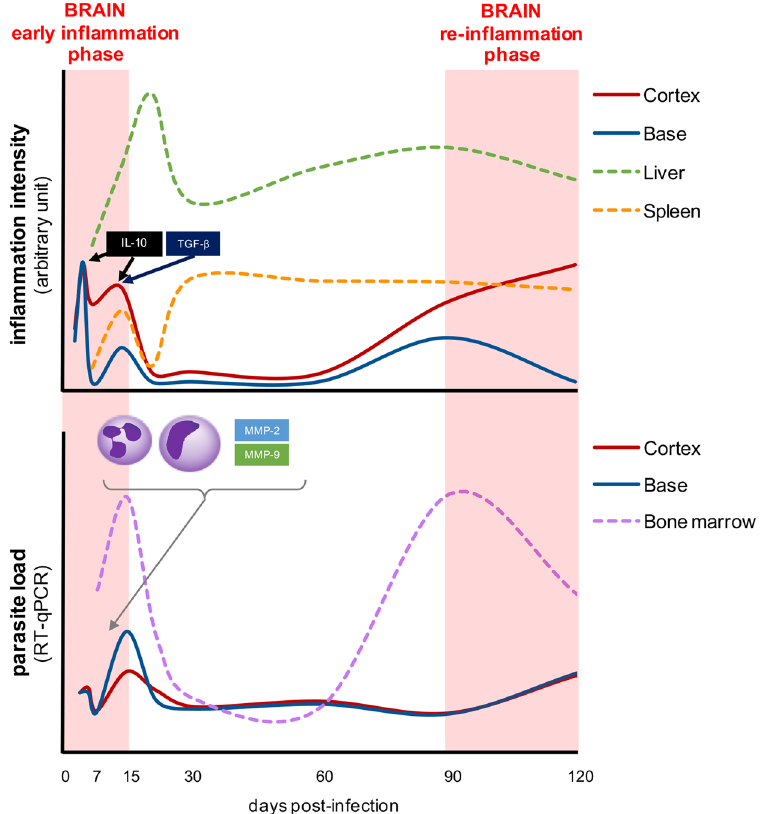
Figure 6. Inflammation dynamics in the brain of BALB/c mice infected with Leishmania donovani . In the upper panel, representative diagram of the inflammation intensity (arbitrary unity derived from the sum of all up-regulated cytokines, chemokines, chemokine receptors and matrix metalloproteinases) observed in the brain (cortex and base; full lines), and liver and spleen (dotted lines) of the infected mice. In the bottom panel, schematic parasite loads (medians) in the brain (cortex and base; full lines) and in the bone marrow (dotted line) of infected mice. Two similar waves can be observed in both panels: the first one, named early inflammation phase (light red shaded area), occurs in the first two weeks post-infection, when the peak of inflammation may be related to the arrival of parasites and inflammatory cells in the brain; whereas the second one, named re-inflammation phase (light red shaded area) occurs after 3 months of infection, where the novel increase of inflammatory mediators in the brain may be related to the novel increase of the parasite load in the bone